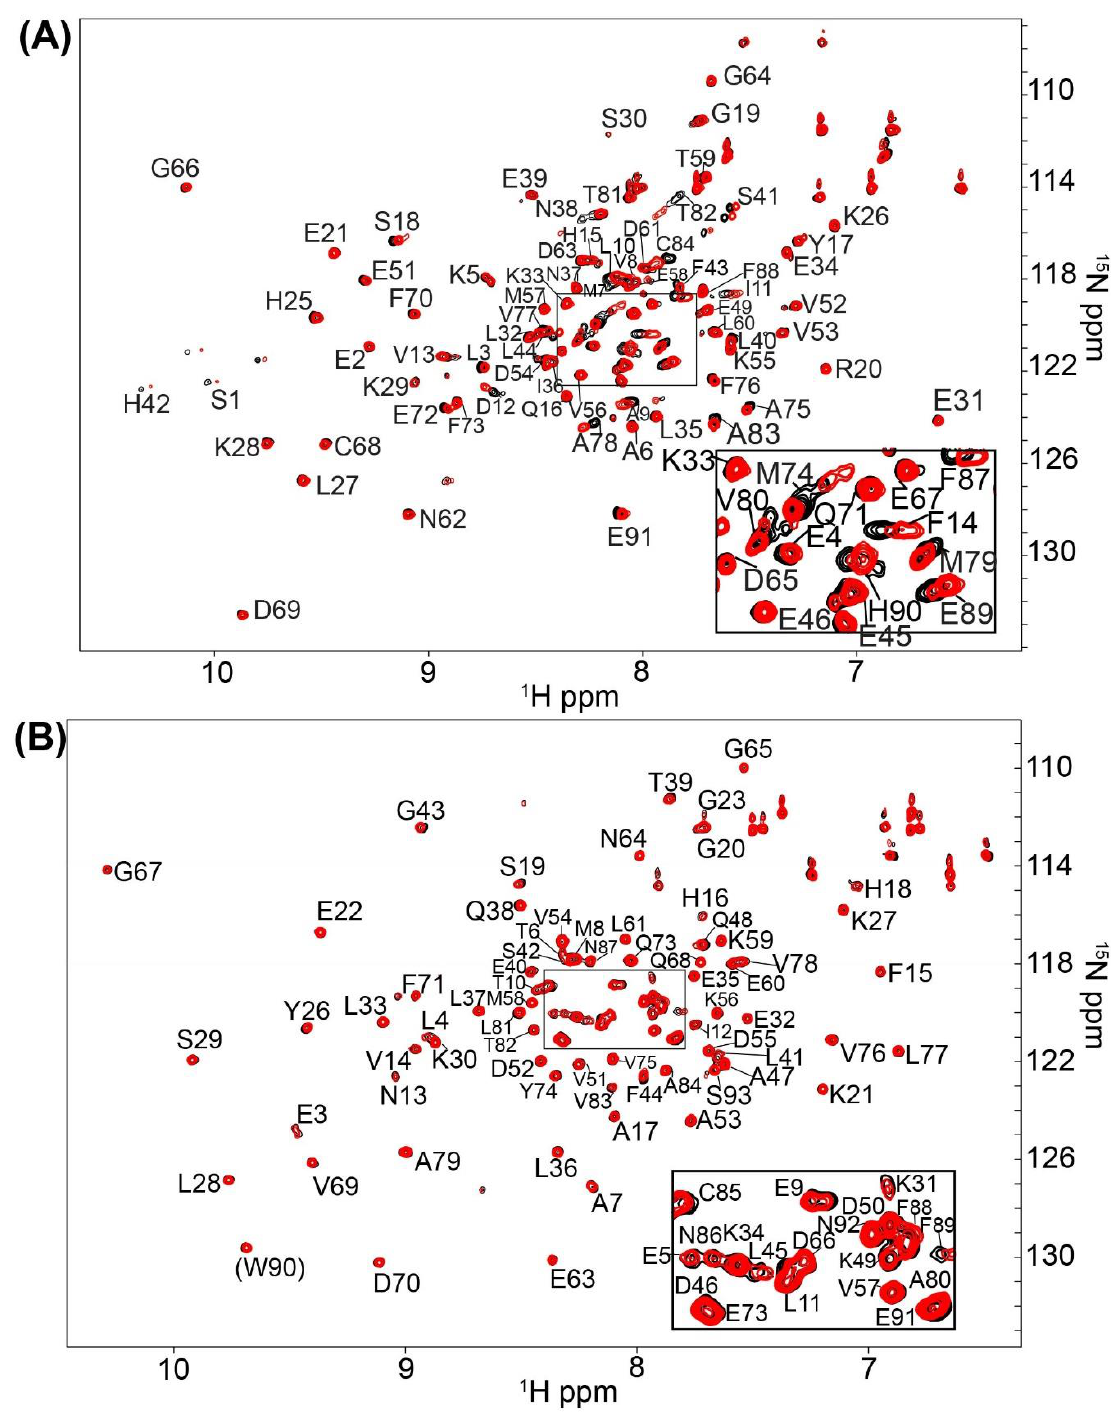
Figure 4. NMR data of S100B and S100A1 in the presence of the S100B specific inhibitor SEW01483. 2D-[ 1 H, 15 N]-HSQC overlays of ( A ) Ca 2+ -S100B and ( B ) Ca 2+ -S100A1 with (red) and without (black) the S100B-specific compound SEW01483. The NMR data was collected in the same manner for both S100 proteins under identical buffer conditions, at 800 MHz, 37 ° C, as described in Methods.